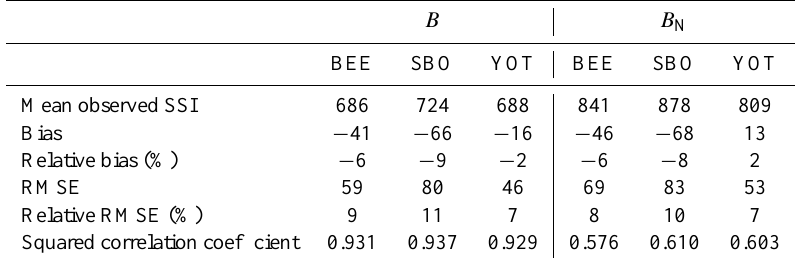
Table 3. Comparison between clear-sky beam SSI B and beam at normal incidence B N measured by ground stations and estimated by McClear. Units in Wm − 2 .